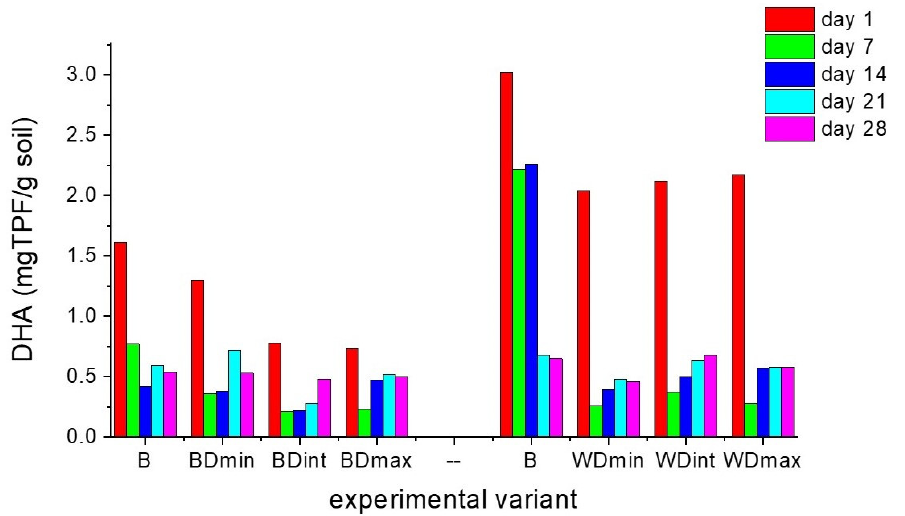
Figure 2. Soil dehydrogenase activity (DHA) for each experimental variant, determined every 7 days for a period of 28 days: B—seeds untreated with triticonazole, BDmin, and WDmin—barley and wheat seeds treated with the minimum dose, DBint, and WDint—barley and wheat seeds treated with the intermediate dose, BDmax, and WDmax—barley and wheat seeds treated with the maximum dose of triticonazole.